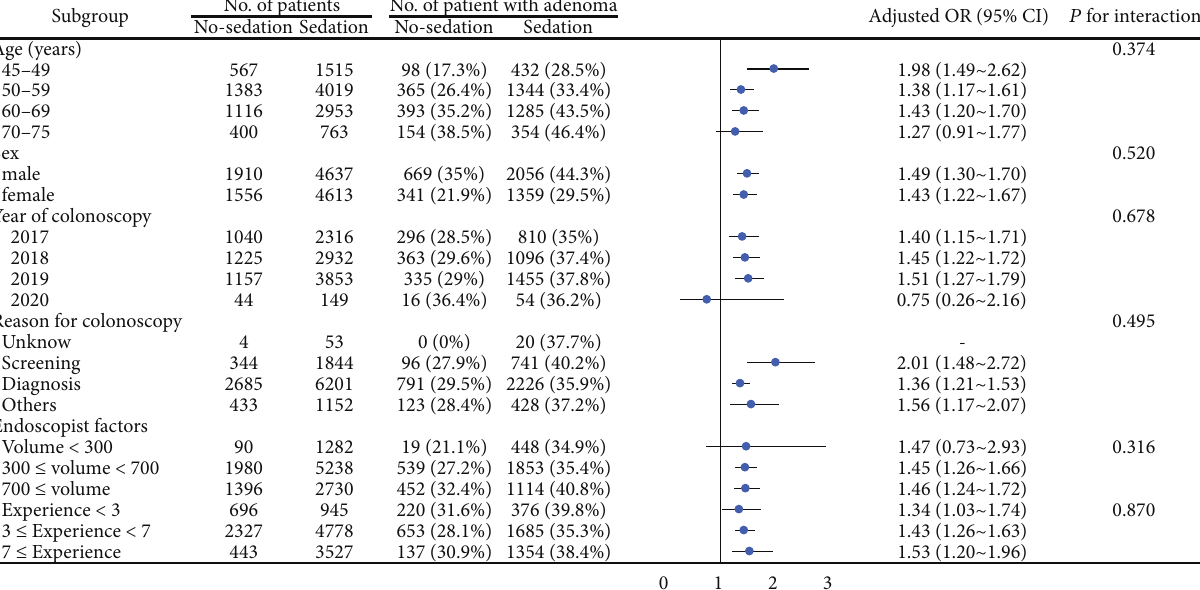
Figure 2: Subgroup analysis of the e ff ect of sedation on ADR. Adjust for: sex; age; year of colonoscopy; time of colonoscopy; reason for colonoscopy; withdrawal time; score of BBPS; volume of endoscopist; and experience of endoscopist.